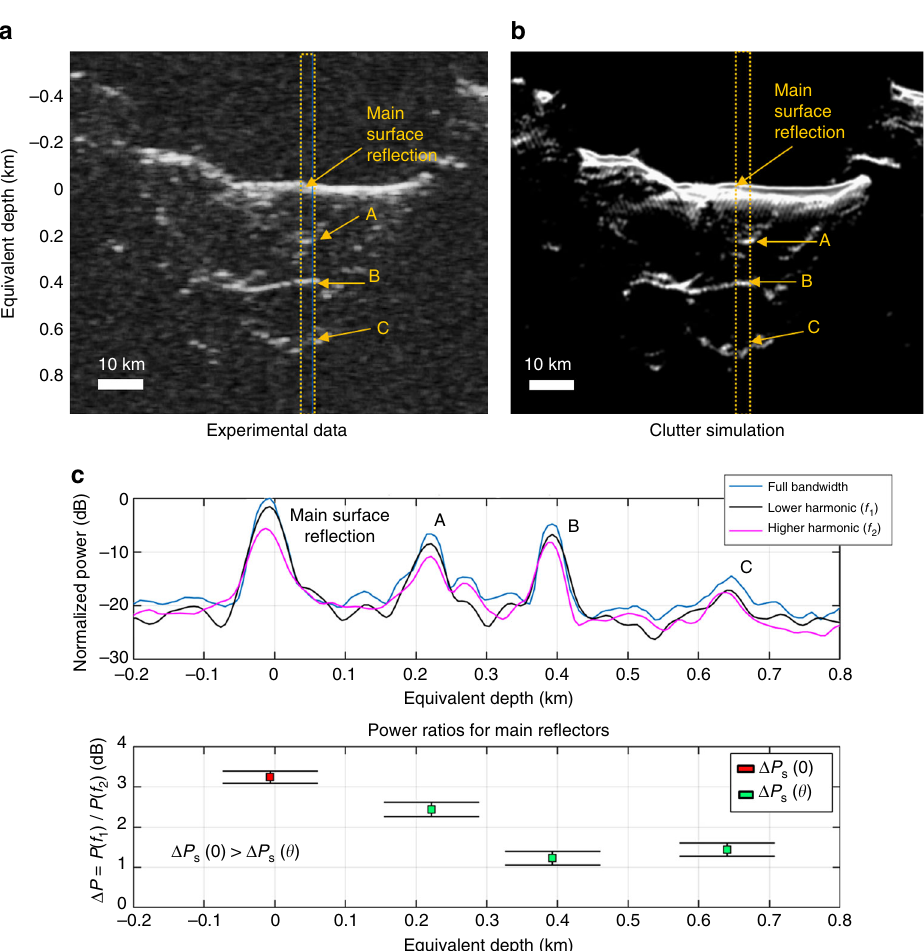
Fig. 7 Example of clutter detection in the South Polar region. Example of the bio-inspired model results for a portion of the SHARAD radargram 0263001. The radargram is acquired over South Polar region near Promethei Rupes and contains only clutter features that resemble subsurface echoes. The disambiguation condition on clutter Δ P s (0) ≥ Δ P s ( θ ) is veri fi ed allowing the clutter discrimination to be effectively performed. a SHARAD radargram 0263001. The dashed orange box is the region under investigation. Main off-nadir clutter re fl ector regions are marked with letters from A to C. b Clutter simulation con fi rming that the re fl ections are generated by surface features only. In this case, the clutter is generated by different craters walls. c Upper plot depicts echo traces (average over the investigated region) for the full signal and the harmonics decomposition. The lower plot shows the mean and standard deviation of power ratios for main re fl ectors. The number of echo traces considered for deriving the statistics is equal to 500. The equivalent depth in the subsurface medium has been computed from time delay assuming ε =